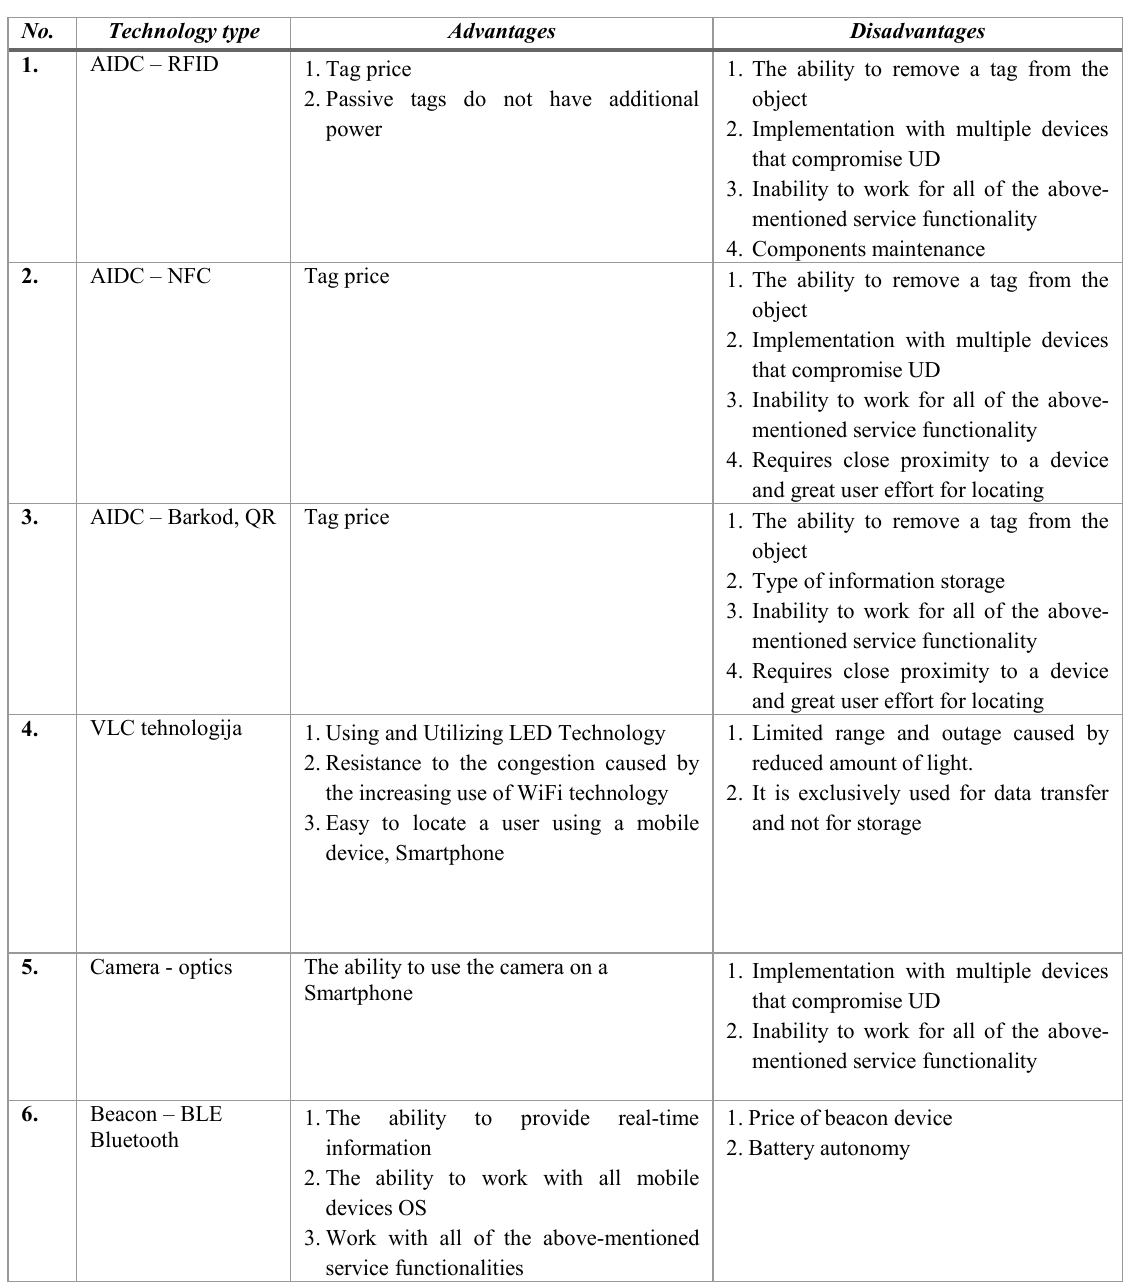
Table 1 . Possibilities of using ICT in indoor